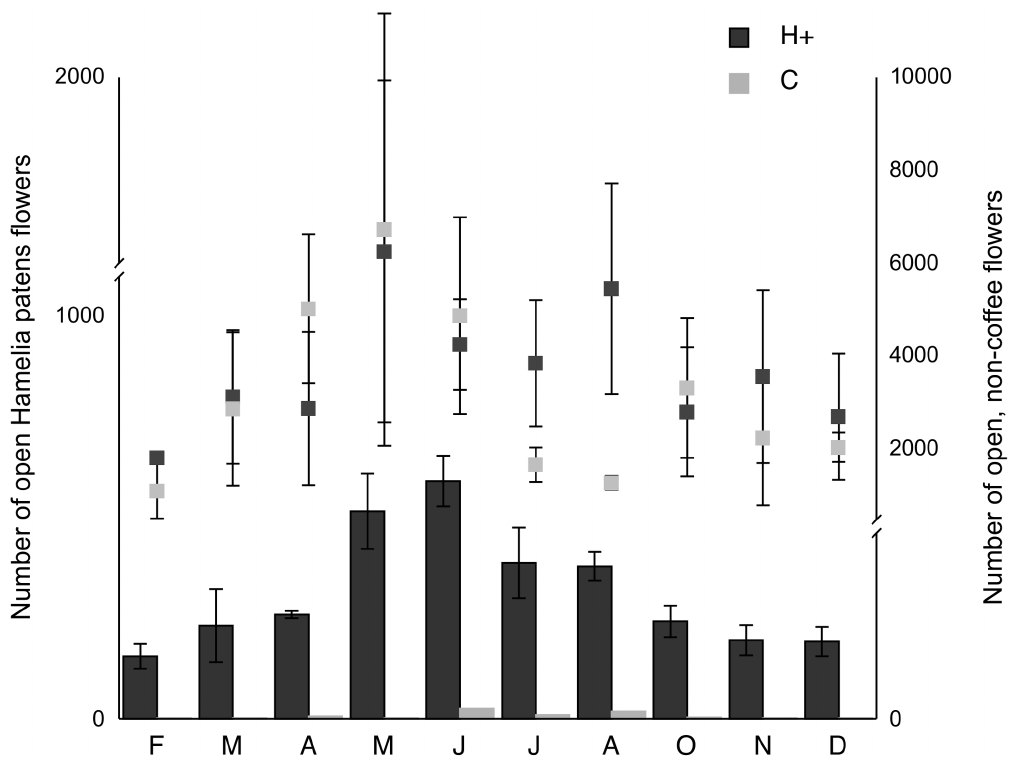
Figure 3. Seasonality of floral resources in coffee agroforests. Hamelia patens blooms (first y-axis) and open, non-coffee flowers (second y-axis). H + represents agroforests with supplemental H. patens plantings and C represents control agroforests.